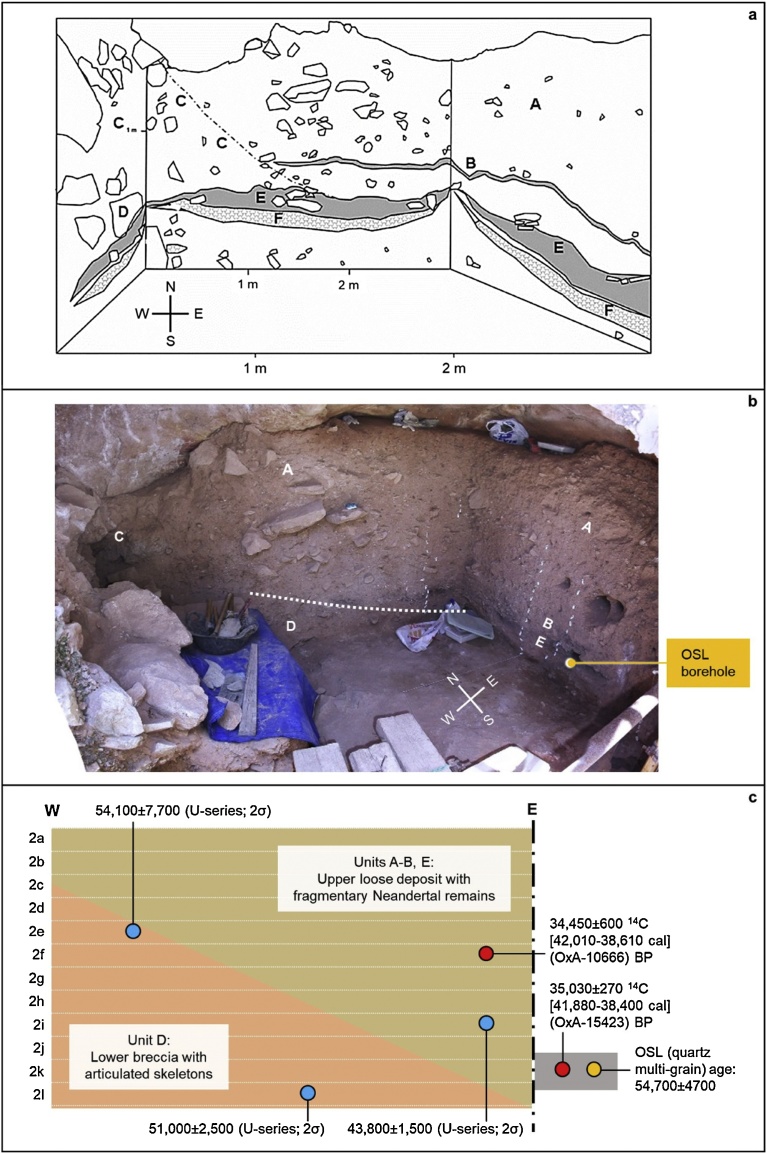
Sima de las Palomas de Cabezo Gordo, Upper Cutting. a. Schematic drawing of the stratigraphy [after (Walker et al., 2008) (Walker et al., 2012), modified]. b. Composite mosaic view over the north and east walls of the Upper Cutting excavation trench during the 2007 field season. c. Schematic position of the radiocarbon- and U-series-dated samples relative to stratigraphy and arbitrary horizontal spits of provenience (2a-to-2l).